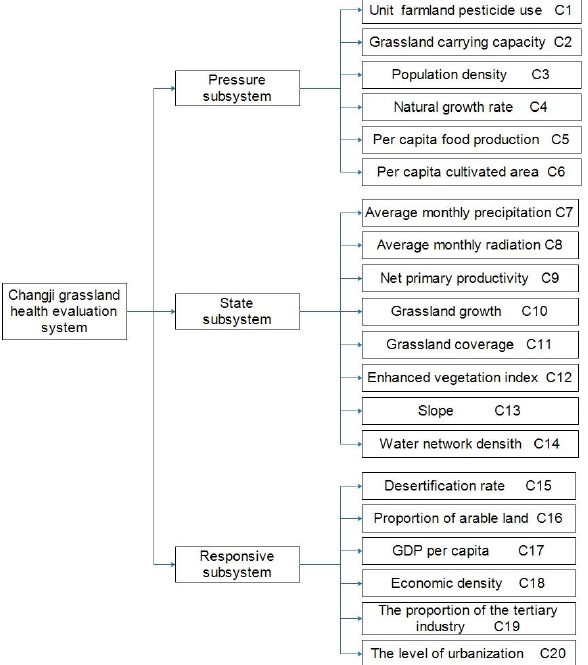
Figure 1.Location of Changji Prefecture